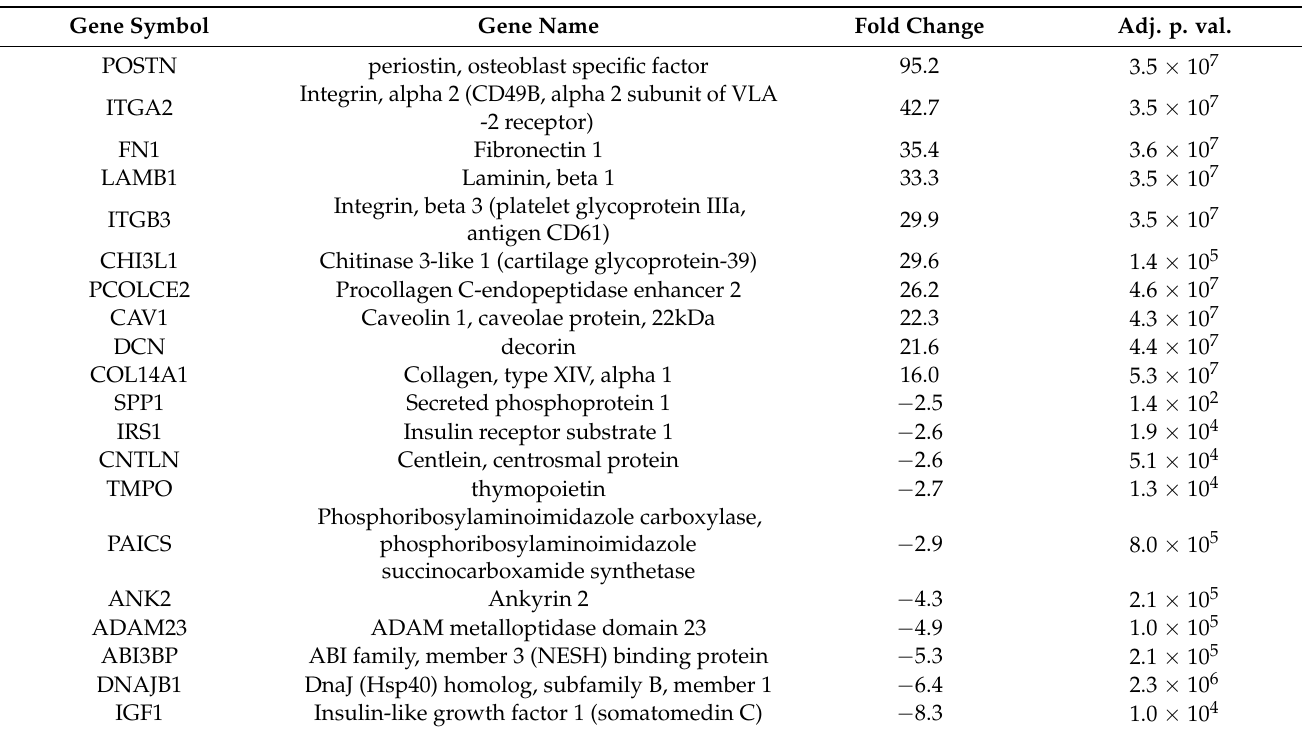
Table 2. The 10 most significantly upregulated and 10 most significantly downregulated genes involved in cadherin and collagen binding and structuralization of extracellular matrix components.